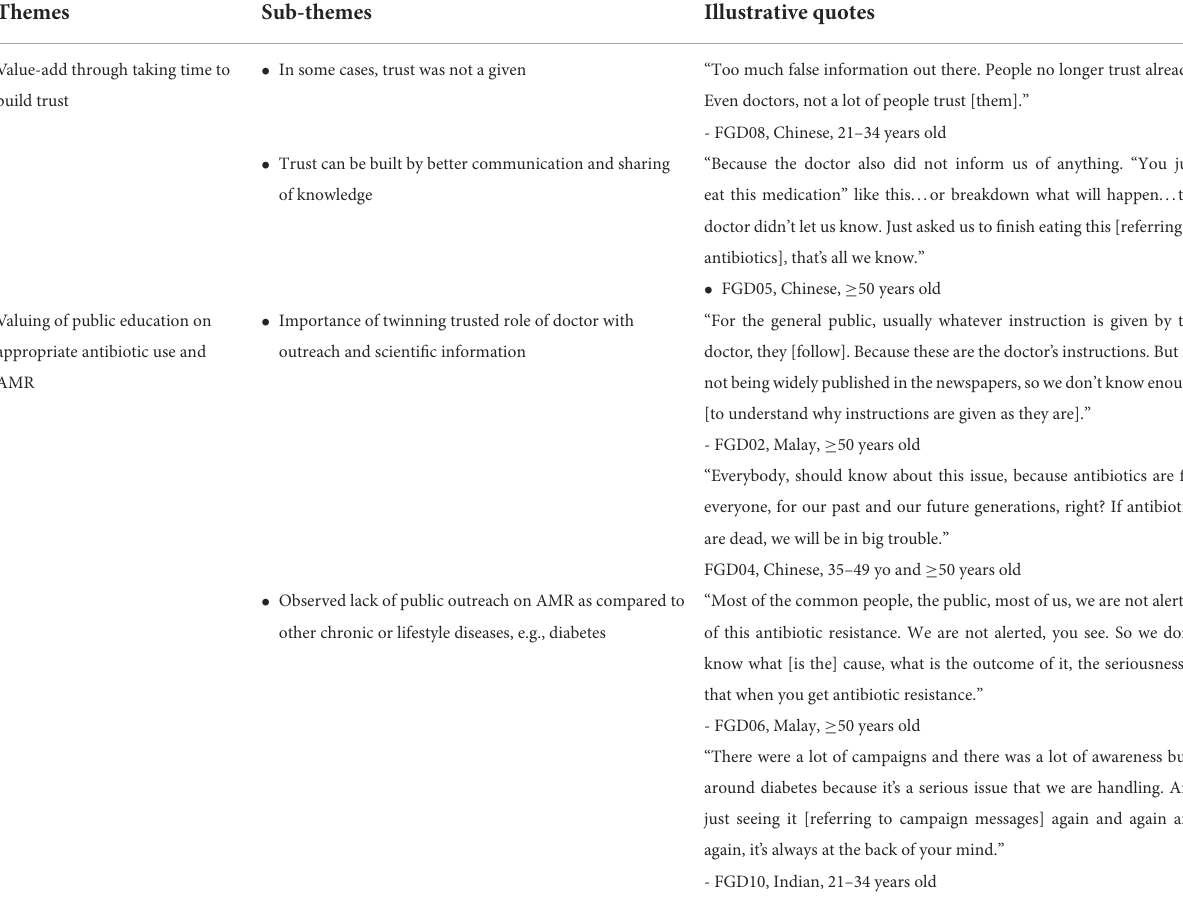
TABLE 3A Trust building, themes collated from focus group discussion